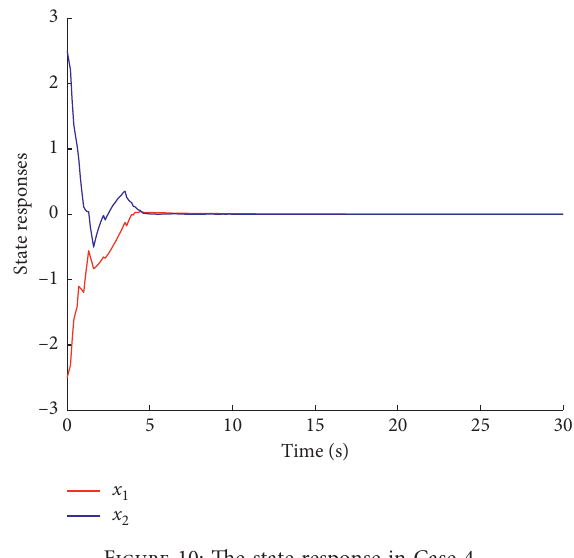
Figure 7: The state response in Case 3.